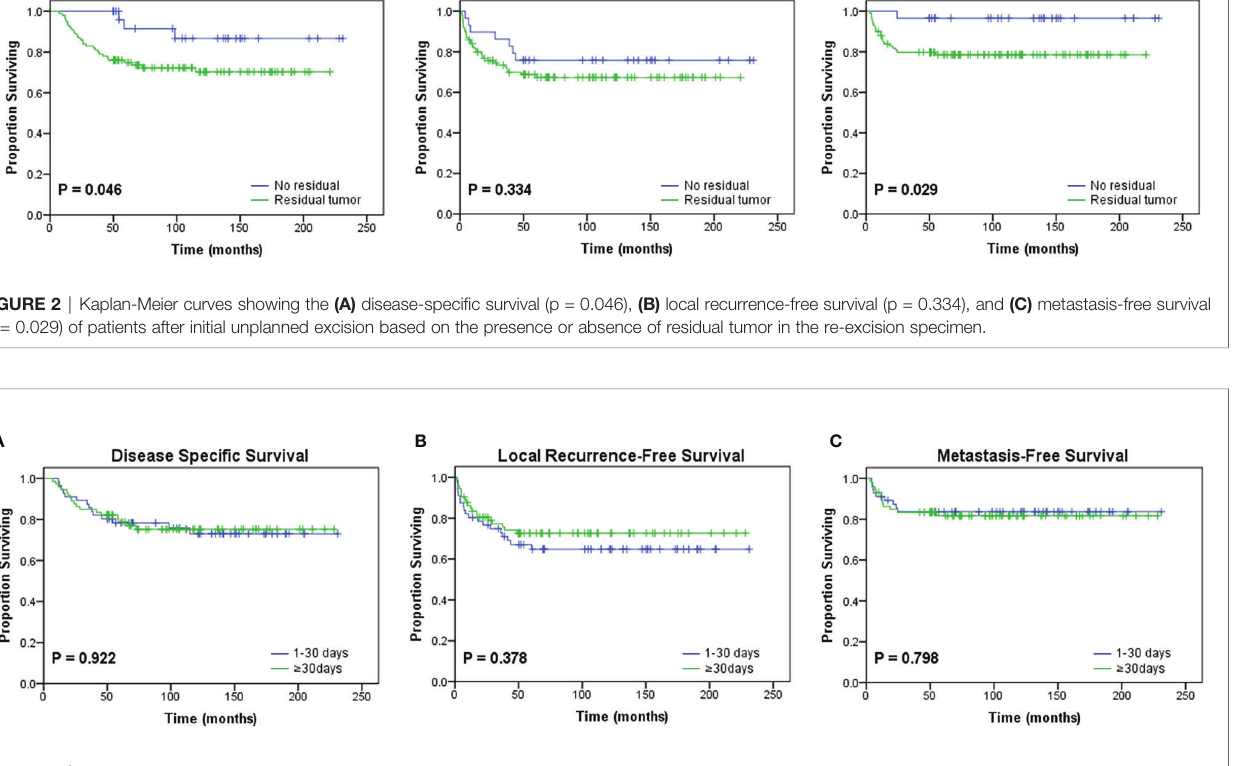
FIGURE 3 | Kaplan-Meier curves for oncologic outcomes according to the interval from unplanned excision to de fi nitive surgery. No differences in (A) disease- speci fi c survival (p = 0.922), (B) local recurrence-free survival (p = 0.378), or (C) metastasis-free survival (p = 0.798) were observed between the two groups divided by the median interval value (30 days).